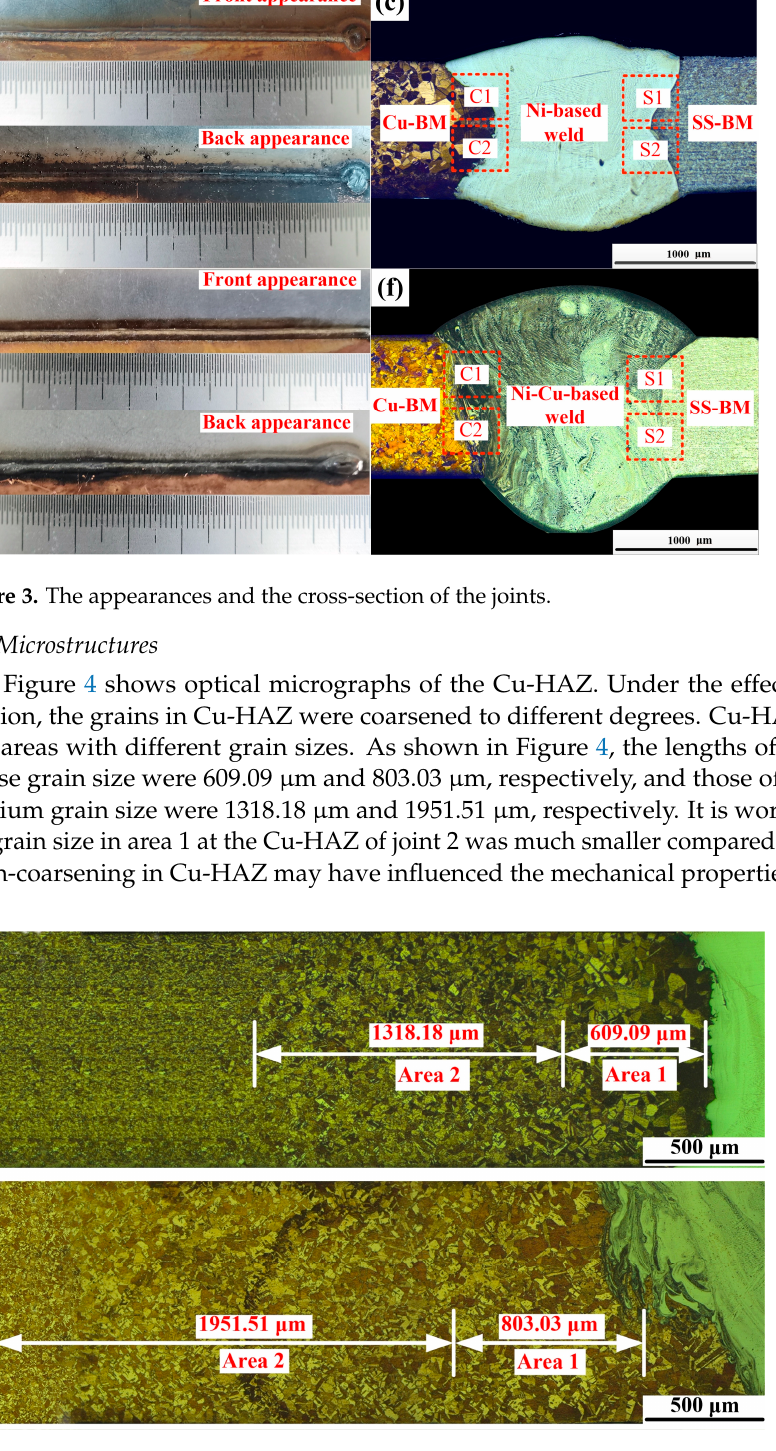
Figure 4. Optical micrographs of the Cu-HAZ: ( a ) joint 1 and ( b ) joint 2.